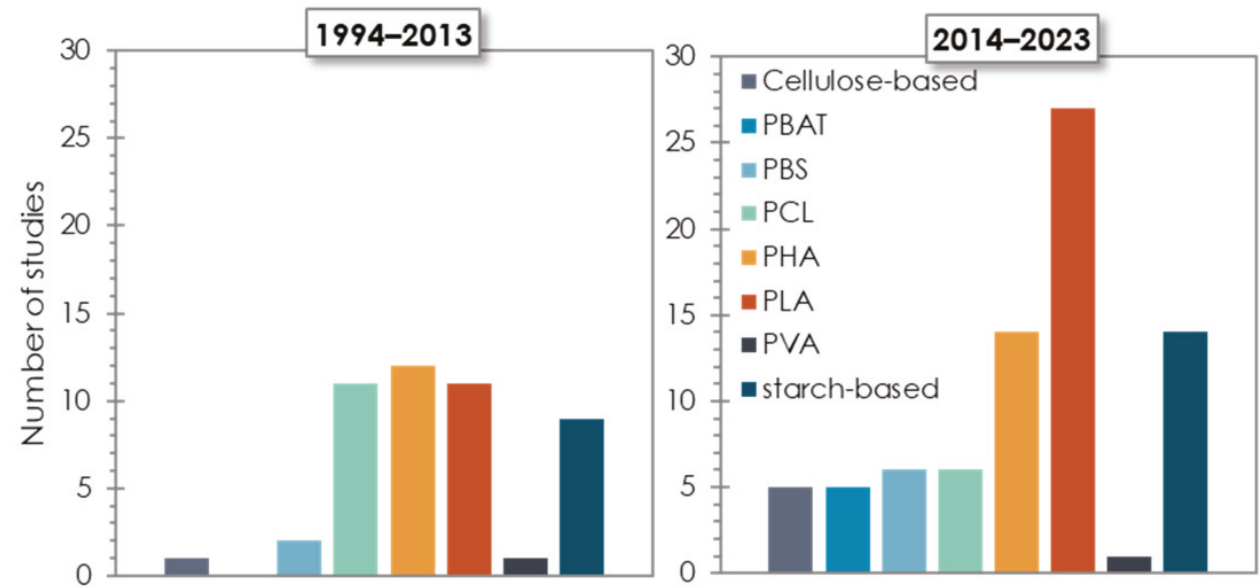
Figure 4. Number of studies on the different biopolymers for mesophilic ( left ) and thermophilic ( right ) conditions.